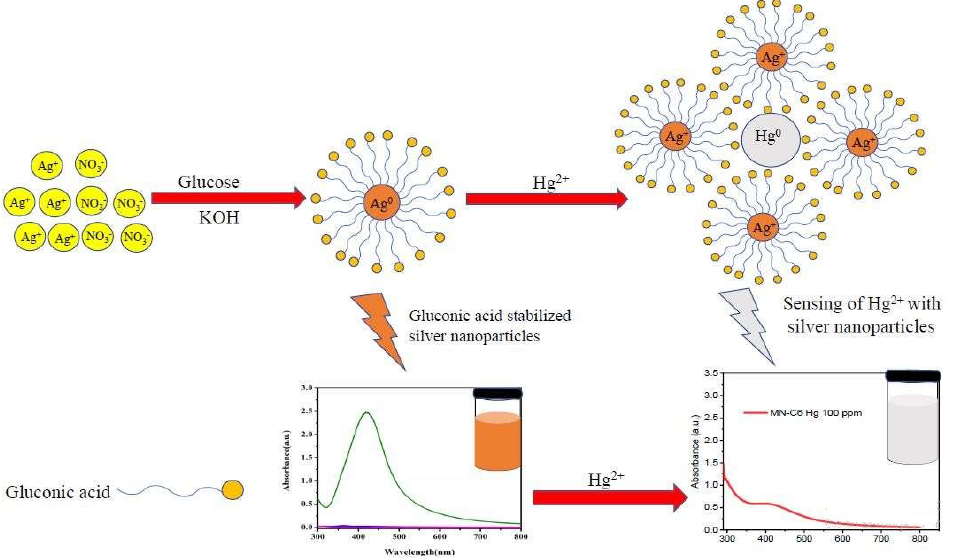
Table 3. Experimental details for the screening of different heavy metals by